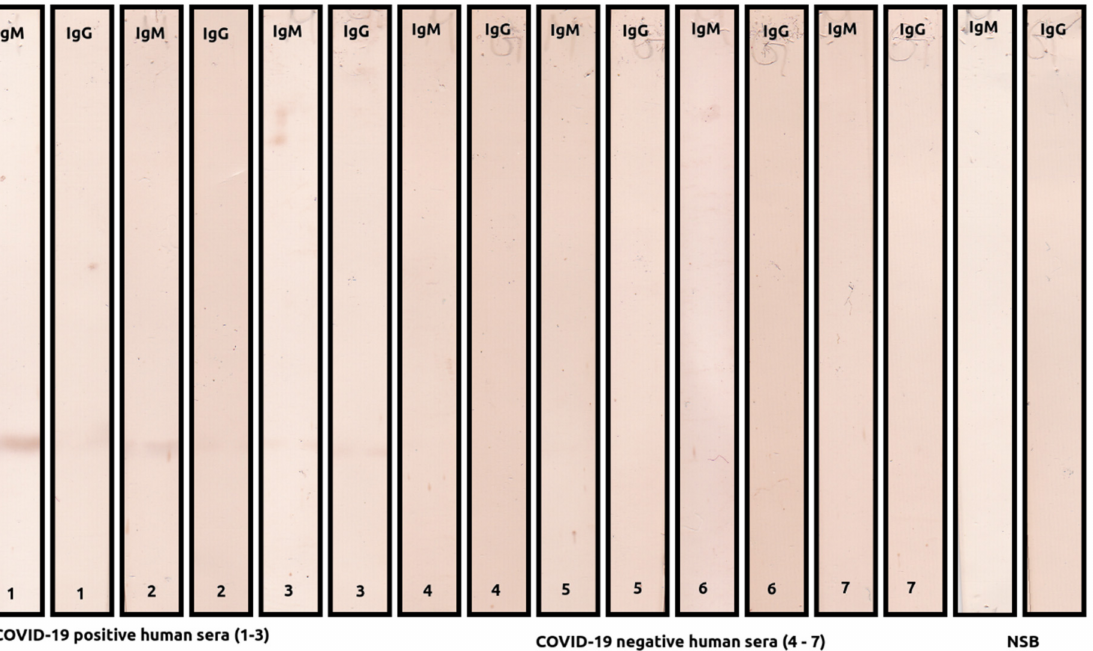
Figure 3. Representative Western blots showing the reaction of sera from COVID-19 subjects (samples 1 − 3) and healthy individuals (samples 4 − 7); NSB–nonspecific binding of anti-human IgM and IgG